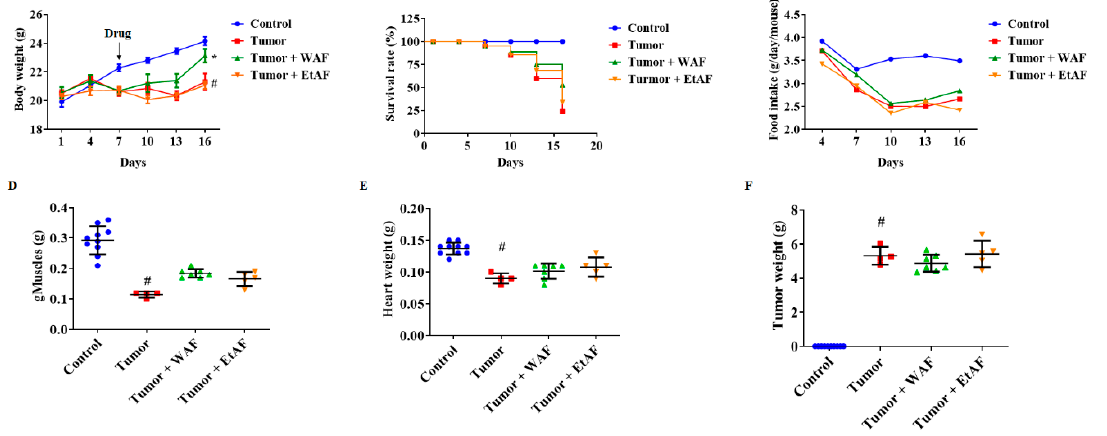
Figure 5. Effects of AF on mortality and cachectic symptom in intraperitoneally CT-26 tumor-bearing mice. CT-26 cells were intraperitoneally injected into the mice ( n = 10). 100 mg/kg/day of WAF and EtAF were orally administrated every day. Weight changes for 16 days were measured on the indicated day ( A ). Survival rate ( B ) and food intake ( C ) were measured on the indicated day. The weights of gMuscle ( D ), heart ( E ), and tumor ( F ) were measured after sacrificing the mice. All values are mean ± SD. # p < 0.05, significantly different from control group; * p < 0.05, significantly different from tumor group.